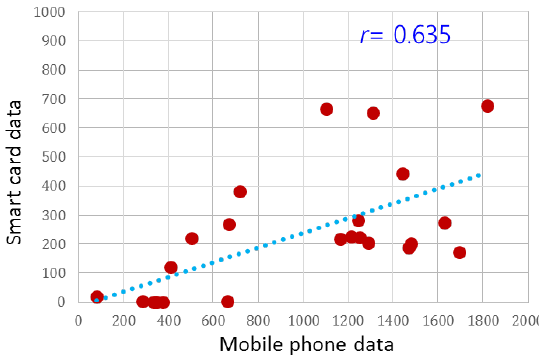
Figure 8. Scatter plot of hourly travel volumes inferred from smart card data and mobile phone data